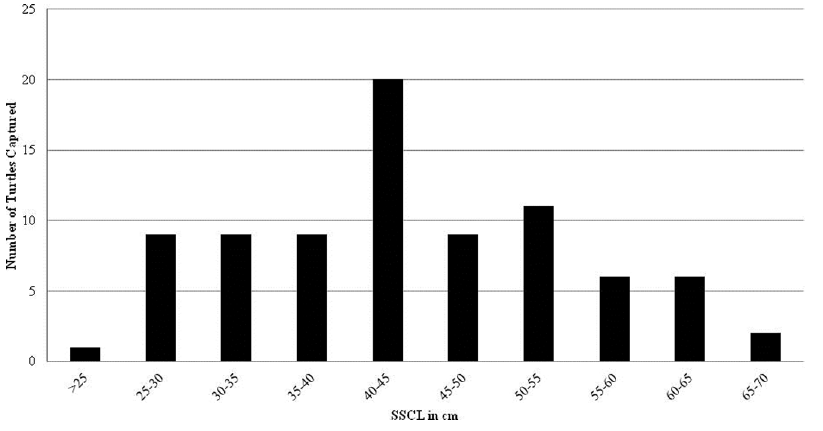
Fig. 2. Straight standard carapace length (SSCL) size-class distribution of hawksbill turtles for all captures in the Key West National Wildlife Refuge,